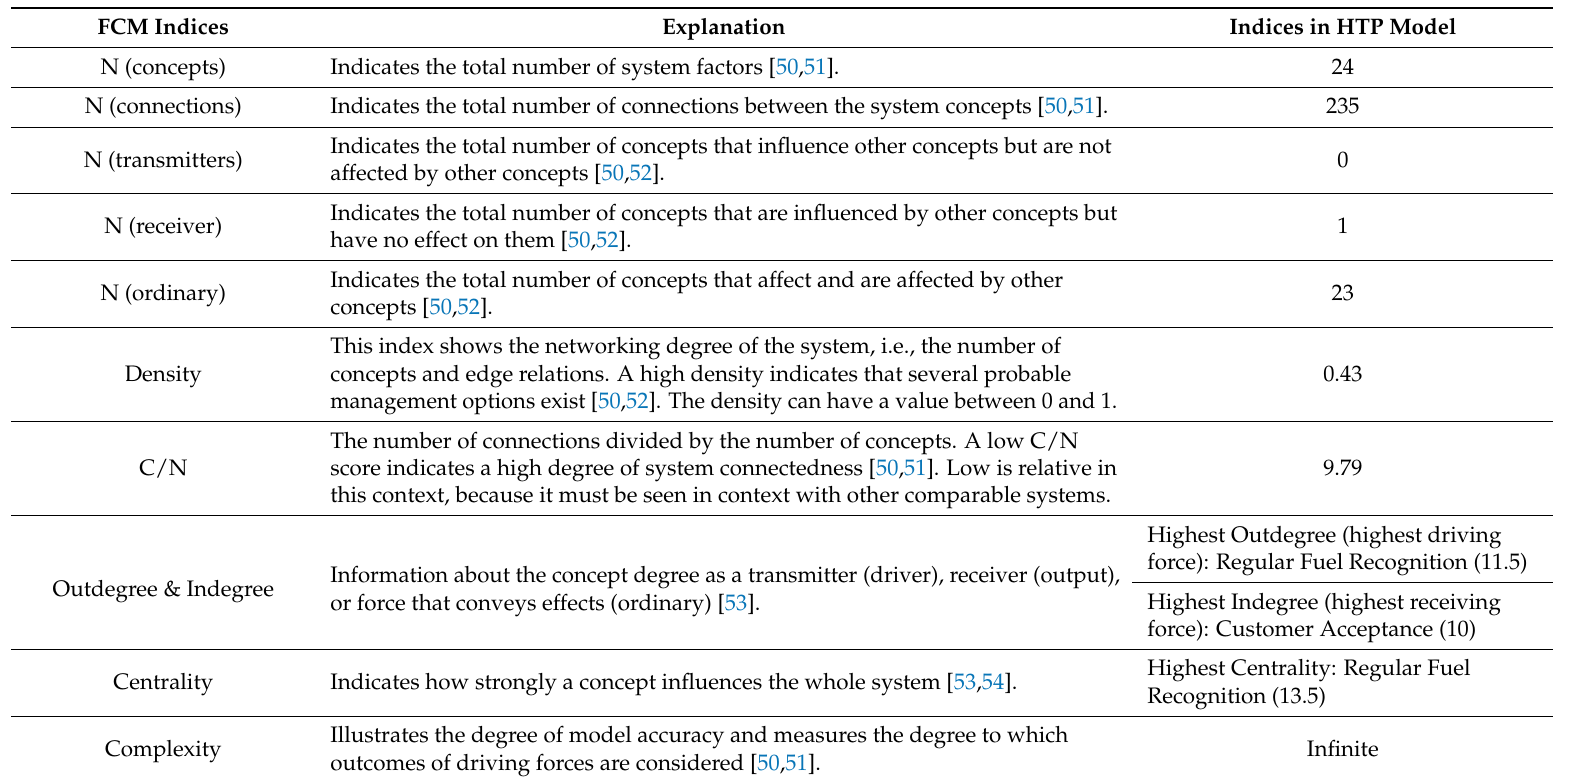
Table 1. FCM indices and their scores in the hydrothermal processes (HTP)